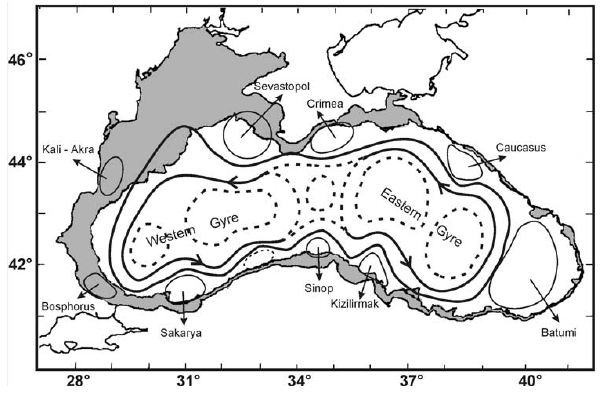
Fig. 1. The schematic diagram for the main features of the upper layer circulation derived from synthesis of past hydrographic stud- ies prior to 1990 and altimetric data (reproduced from its original given by Korotaev et al.